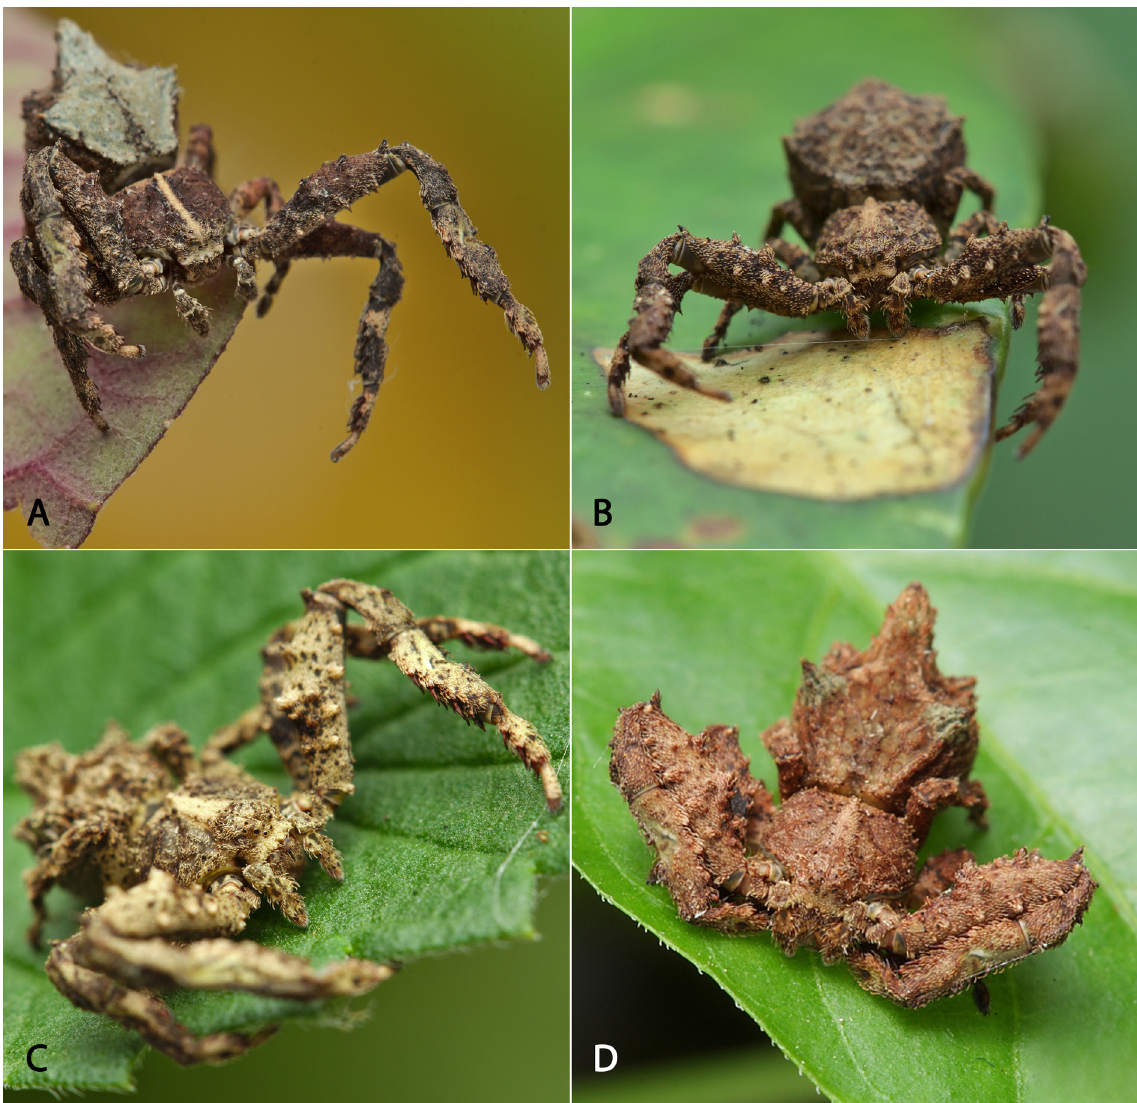
Fig. 2. A–D . Color variations of live specimens of Kryptochroma Machado gen. nov. Photo credits: Thiago